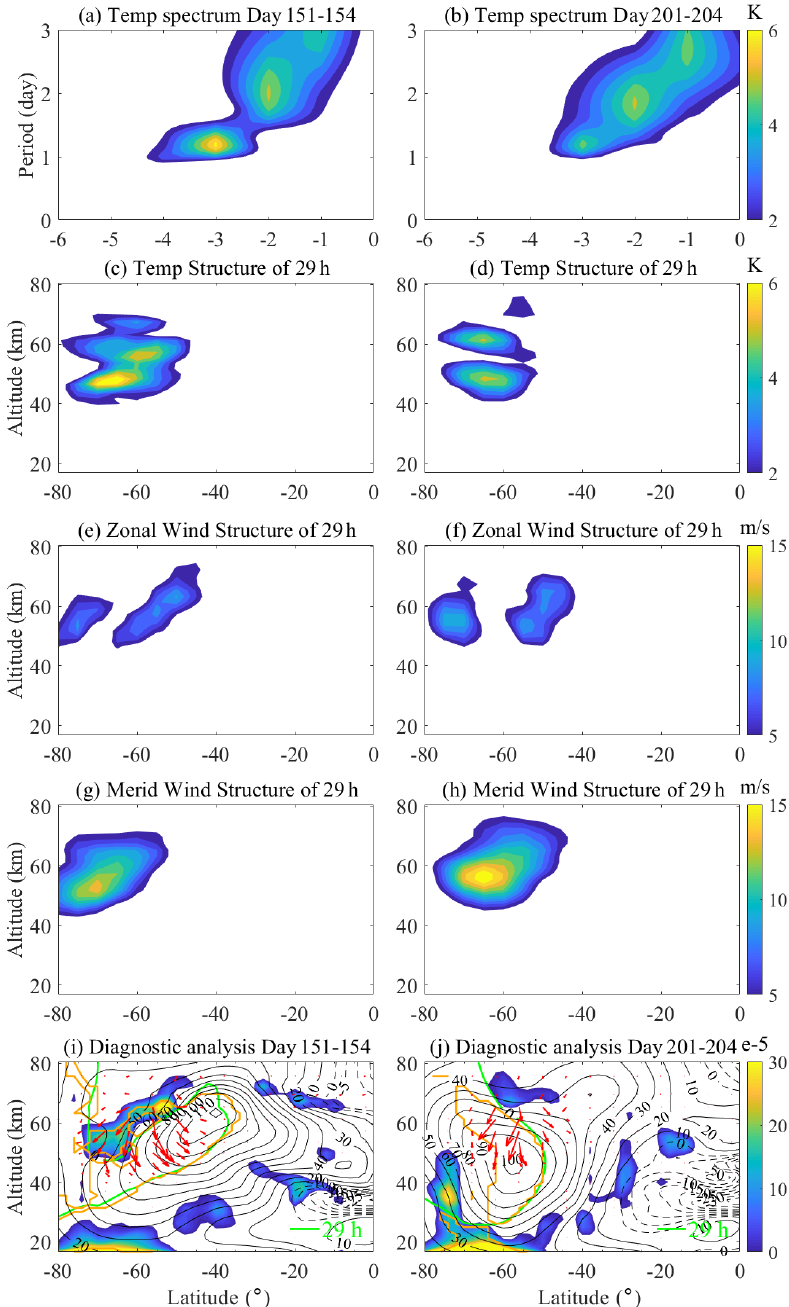
Figure 6. Same as Fig. 4 but for E3 during the 2019 austral winter